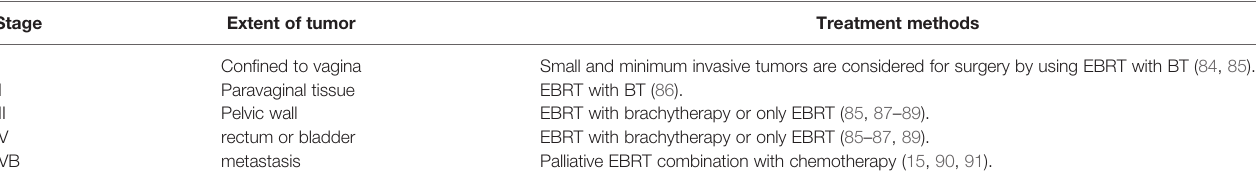
TABLE 1 | Treatment of vaginal cancer by International Federation of Gynecology and Obstetrics ’ stage.